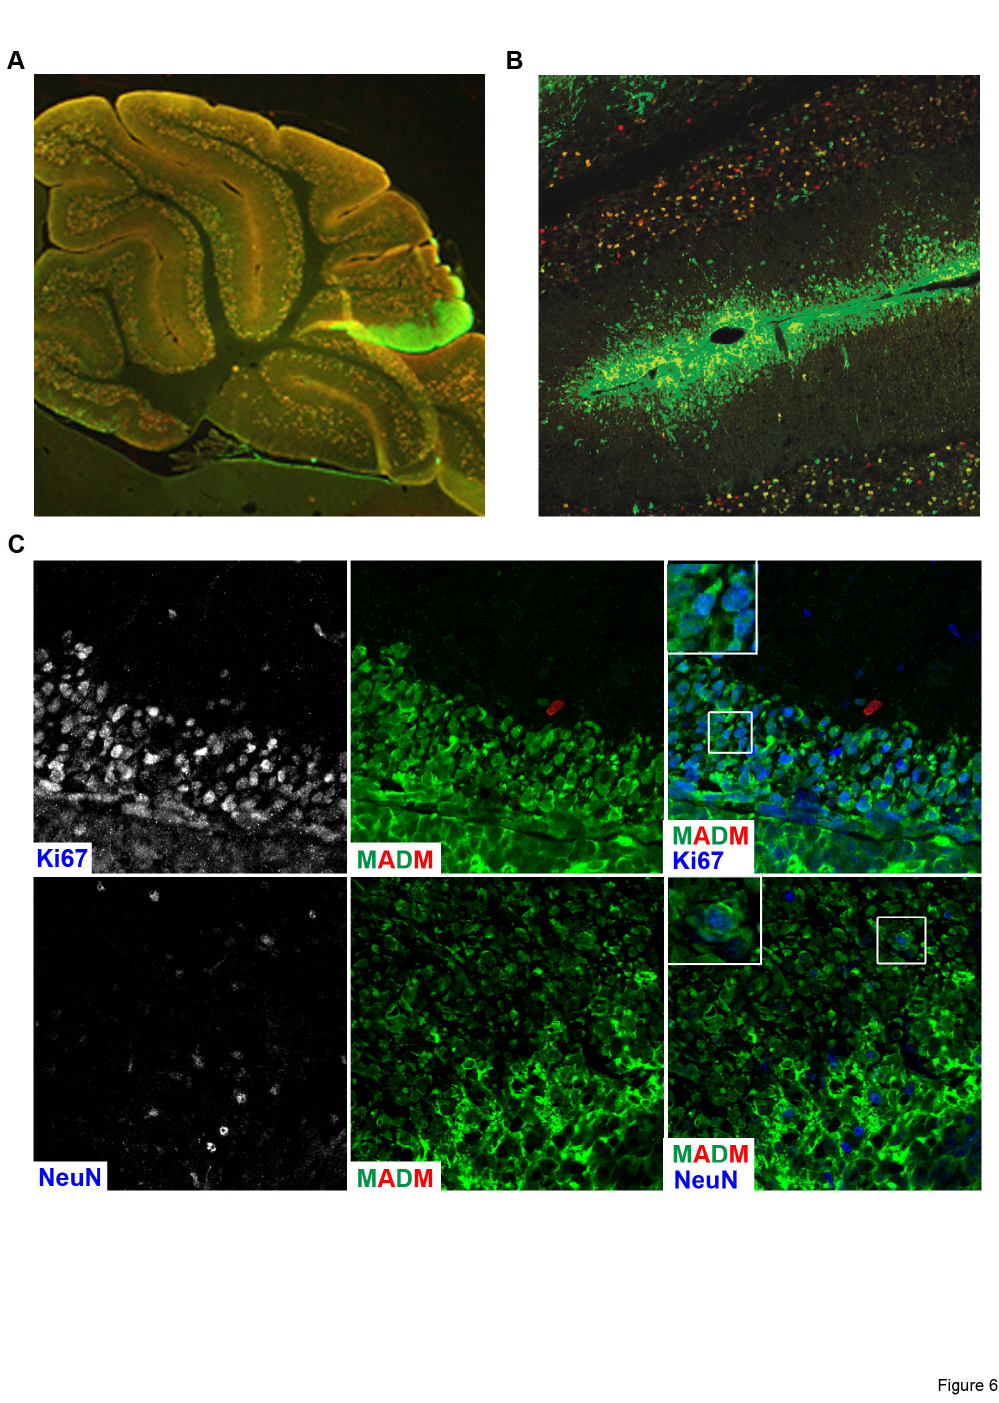
Figure 6. MADM allows visualization of early lesions and detailed tumor organization. (A) A representative brain section from a MADM-generated medulloblastoma. The GFP-labeling of mutant cells amidst sparse background labeling of granule neurons clearly identifies early lesion sites consisting of only hundreds to thousands of cells in a P90 mouse. (B) Tumor cells in the small lesion are GFP+, suggesting that p53 loss is critical for malignant transformation. (C) Co-staining of GFP with proliferation or differentiation markers allows us to perform detailed analysis of tumor organization. Top panels show many actively dividing tumor cells that are Ki67+ GFP+ (inset is a zoomed-in image showing clear GFP/Ki67 overlap). Bottom panels show NeuN+ GFP+ cells within the tumor mass, suggesting that some tumor cells differentiate into neurons (inset is a zoomed-in image showing clear GFP/ NeuN overlap). doi: 10.1371/journal.pone.0077672.g006 PLOS ONE |